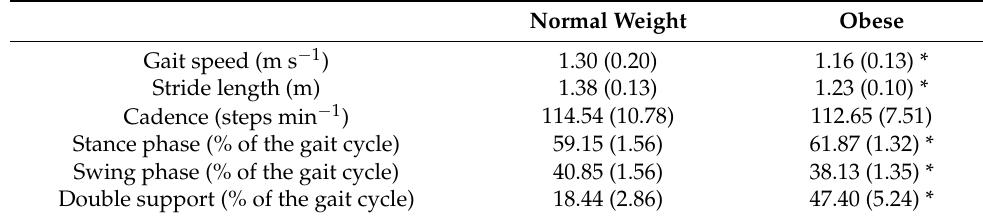
Table 2. Comparison between the spatio-temporal gait parameters of normal weight and obese individuals. Values are expressed as mean